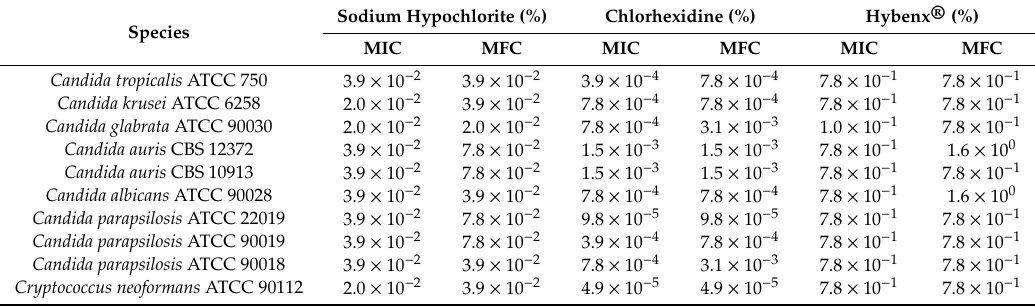
Table 2. Minimal inhibitory and fungicidal concentrations (MIC and MFC, respectively) of HybenX ® , sodium hypochlorite and chlorhexidine on a collection of different Candida spp. and Cryptococcus neoformans . Sodium Hypochlorite (%) Chlorhexidine Species